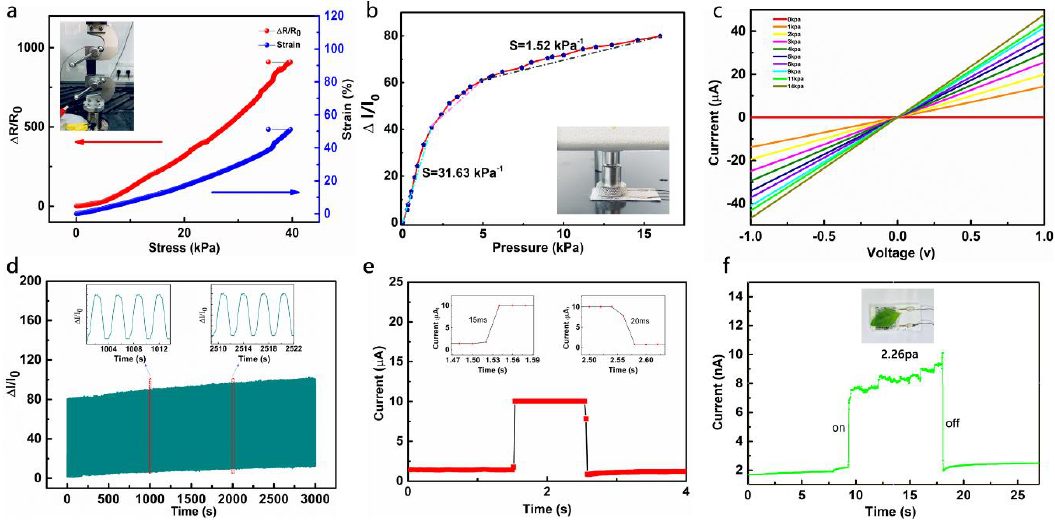
Figure 4. Basic electromechanical sensing performance: ( a ) Relative change in resistance and strain when the NCB-coated PDMS is pulled up and inset image of its measuring equipment. ( b ) Relative change in the current of the pressure sensing when the pressure increases from 0 to 15 kPa and inset image of its measuring equipment. ( c ) I–V curves under different pressures. ( d ) The circulation testing of the NCB sensor with applied pressure of 15 kPa. ( e ) Response/release time of the NCB sensor under the pressure of 20 Pa. ( f ) The loading and shift of a leaf on the NCB sensor response to current; the corresponding applied pressure is merely 2.26 Pa.